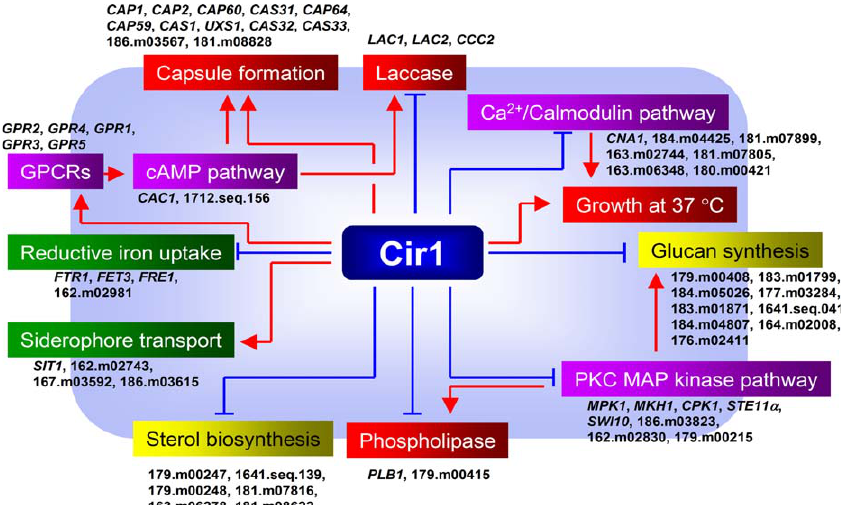
Figure 6. Cir1 Is a Central Regulator of the Iron Regulon, Virulence Factor Expression, and Virulence-Associated Signaling Pathways A schematic of the functions controlled by Cir1 is shown to indicate positive and negative regulation, and interconnections between signalling pathways and downstream target functions. Red arrows indicate positive regulation by Cir1, and blue blunt arrows indicate negative regulation by Cir1. The genes beneath each functional box are downstream targets of Cir1 as experimentally determined by the present study and as listed in Table 3. Gene names are listed for those that have already been characterized; TIGR gene identifiers are used for the other genes. DOI: